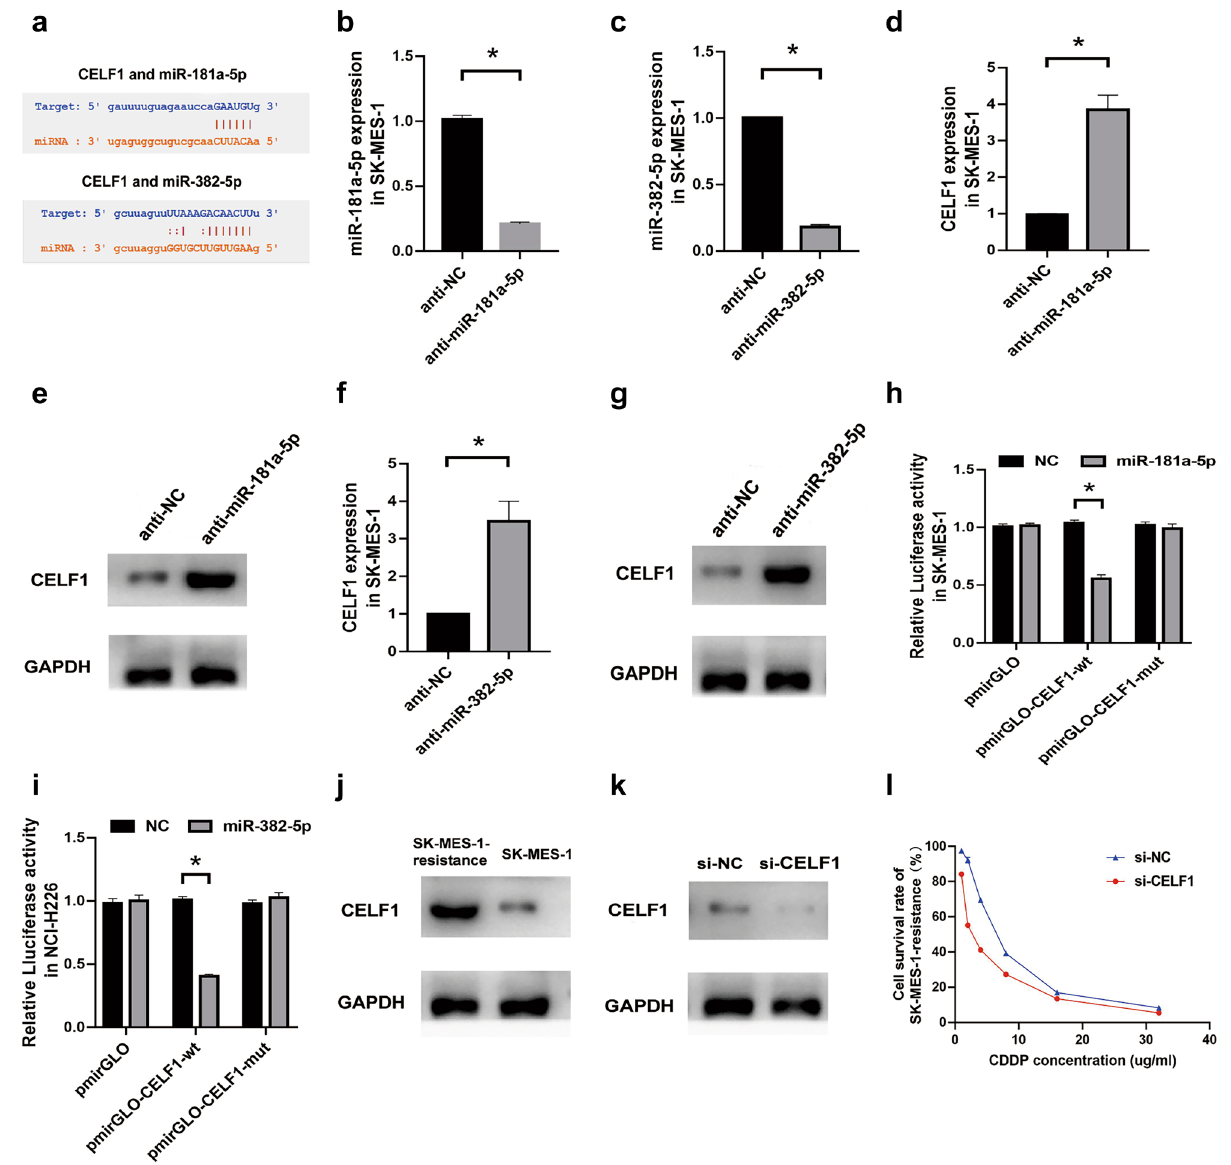
Figure 6. CELF1 served as the target of miR-181a-5p and miR-382-5p. ( a ) The binding sites of CELF1 with miR-181a-5p or miR-382-5p predicted by Starbase. ( b ) qRT-PCR analysis for the relative expression of miR-181a-5p in SK-MES-1 cells transfected with anti-miR-181a-5p or anti-NC. ( c ) qRT-PCR analysis for the relative expression of miR-382-5p in SK-MES-1 cells transfected with anti-miR-382-5p or anti-NC. ( d,e ) qRT-PCR, ( d ) analysis and Western blot, ( e ) analysis for the relative expression of CELF1 in SK-MES-1 cells transfected with anti-miR-181a-5p or anti-NC. ( f,g ) qRT-PCR, ( f ) analysis and Western blot, ( g ) analysis for the relative expression of CELF1 in SK-MES-1 cells transfected with anti-miR-382-5p or anti-NC. ( h ) The binding relationship between CELF1 and miR-181a-5p in SK-MES-1 cells was verified by performing Dual luciferase reporter gene assay. ( i ) The binding relationship between CELF1 and miR-382-5p in NCI-H226 cells was verified by performing Dual luciferase reporter gene assay. ( j ) The relative expression of CELF1 in SK-MES-1- resistance or SK-MES-1 cells was estimated by Western blot analysis. ( k ) The relative expression of CELF1 in SK-MES-1-resistance transfected with si-CELF1 or si-NC was estimated by Western blot analysis. ( l ) CCK-8 assay for the survival of SK-MES-1-resistance cells transfected with si-CELF1 or si-NC and treated with CDDP. * P <